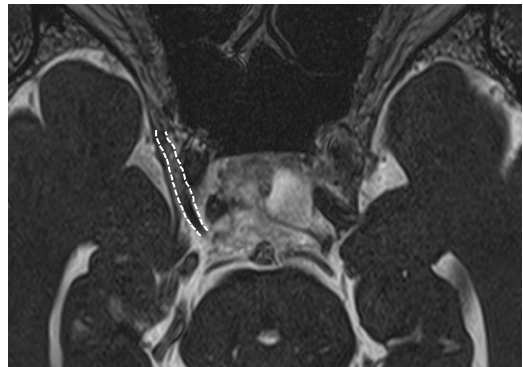
Figure 2. Contrast-enhanced CISS-MRI demonstrates the swelling and enhancement in the right oculomotor nerve (indicated by white dotted lines